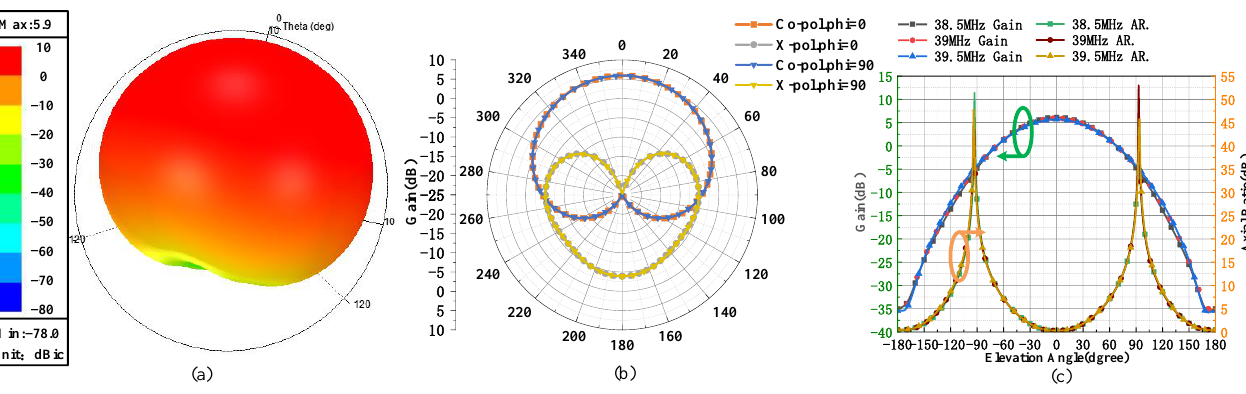
Figure 5. The simulated far-field results of the designed turnstile antenna. ( a ) 3D radiation plot of the proposed antenna; ( b ) Results of coplanar polarization and cross polarization in two orthogonal planes; ( c ) Results of gain and axil ratio.